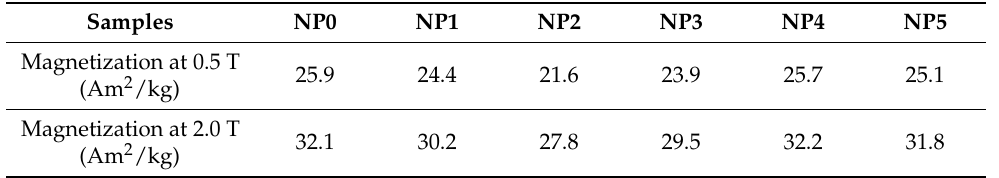
Table 5. Data from measurements of